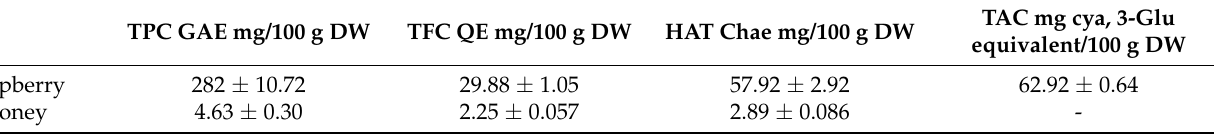
Table 1. The results of total polyphenol content (TPC), total flavonoid content (TFC), total anthocyanin content